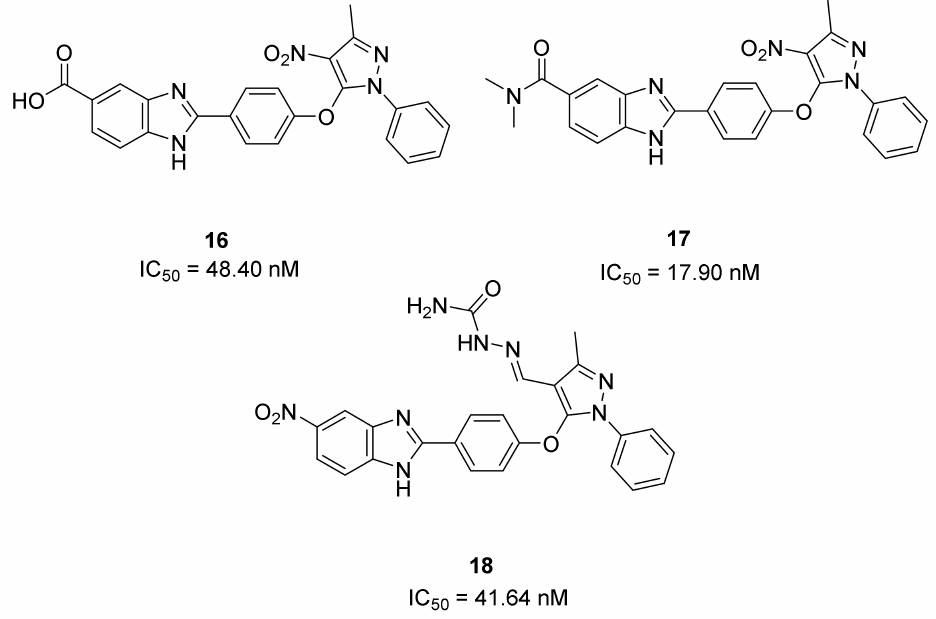
Figure 25. Structures of pyrazole-based checkpoint kinase 2 inhibitors and their IC 50